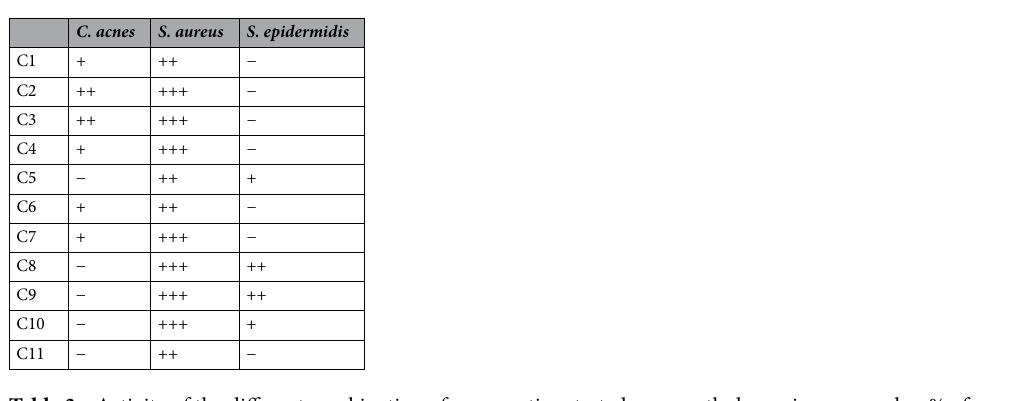
Table 3. Activity of the different combination of preservatives tested on growth dynamic expressed as % of inhibition. +++ strongly inhibited [< 75%]; ++. moderately inhibited [90–80%]; +, weakly inhibited [98–91%]; −, no